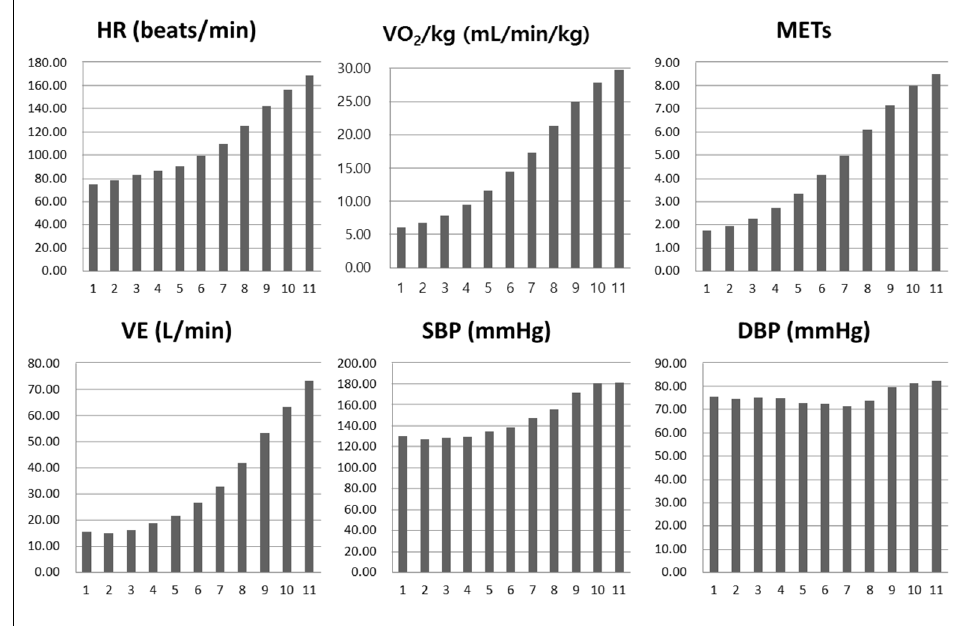
Figure 4. Cardiorespiratory responses during cardiopulmonary exercise test. HR, heart rate; VO 2 , oxygen uptake; METs, metabolic equivalents; VE, minute ventilation; SBP, systolic blood pressure; DBP, diastolic blood pressure. Table 3. Comparison of our new aquatic treadmill protocol data and modified Bruce protocol